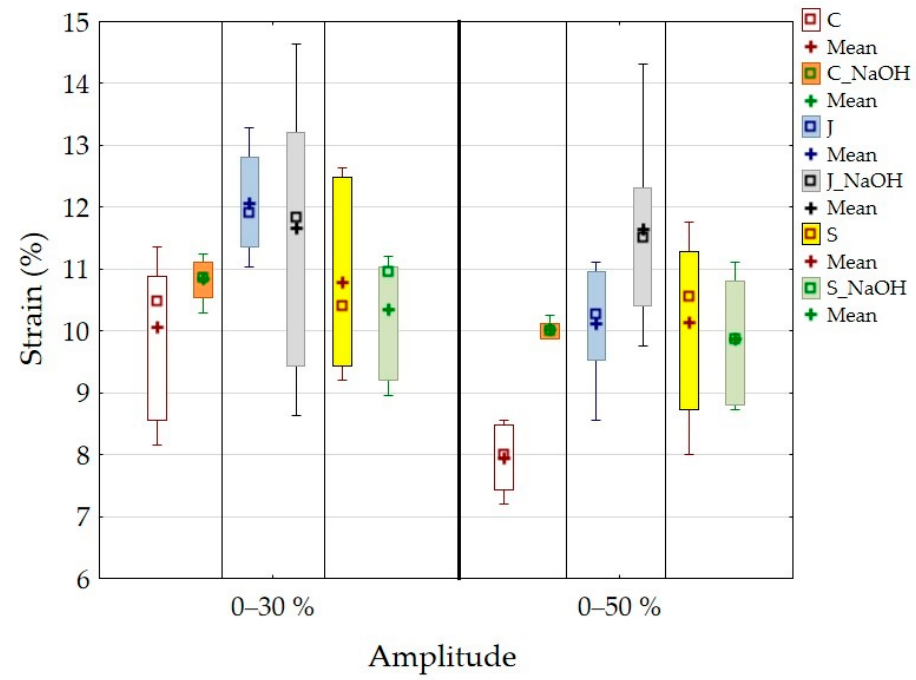
Figure 9. Strain results after cyclic loading of adhesive bonds with a composite adhesive layer.